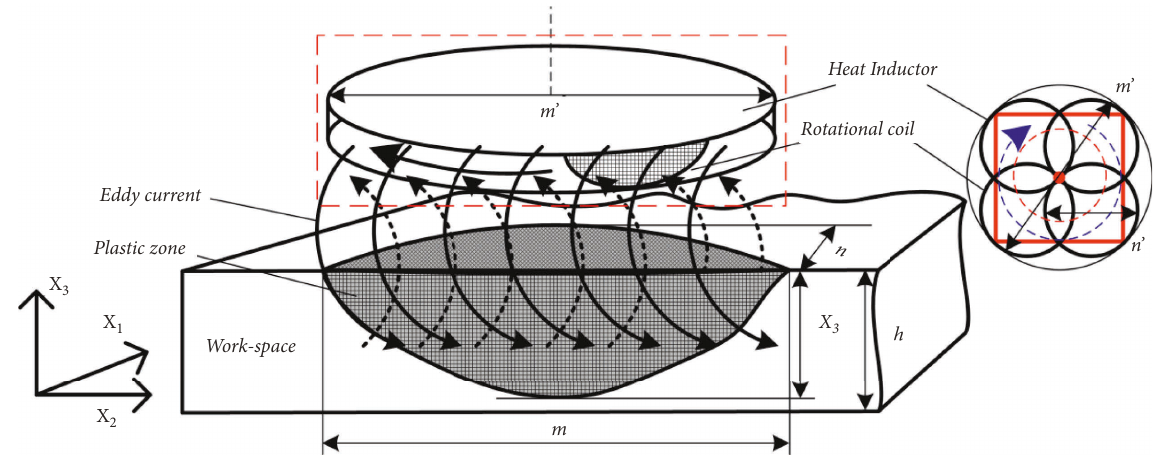
Figure 2: Approximation of induction heating plastic zone 3D Cartesian